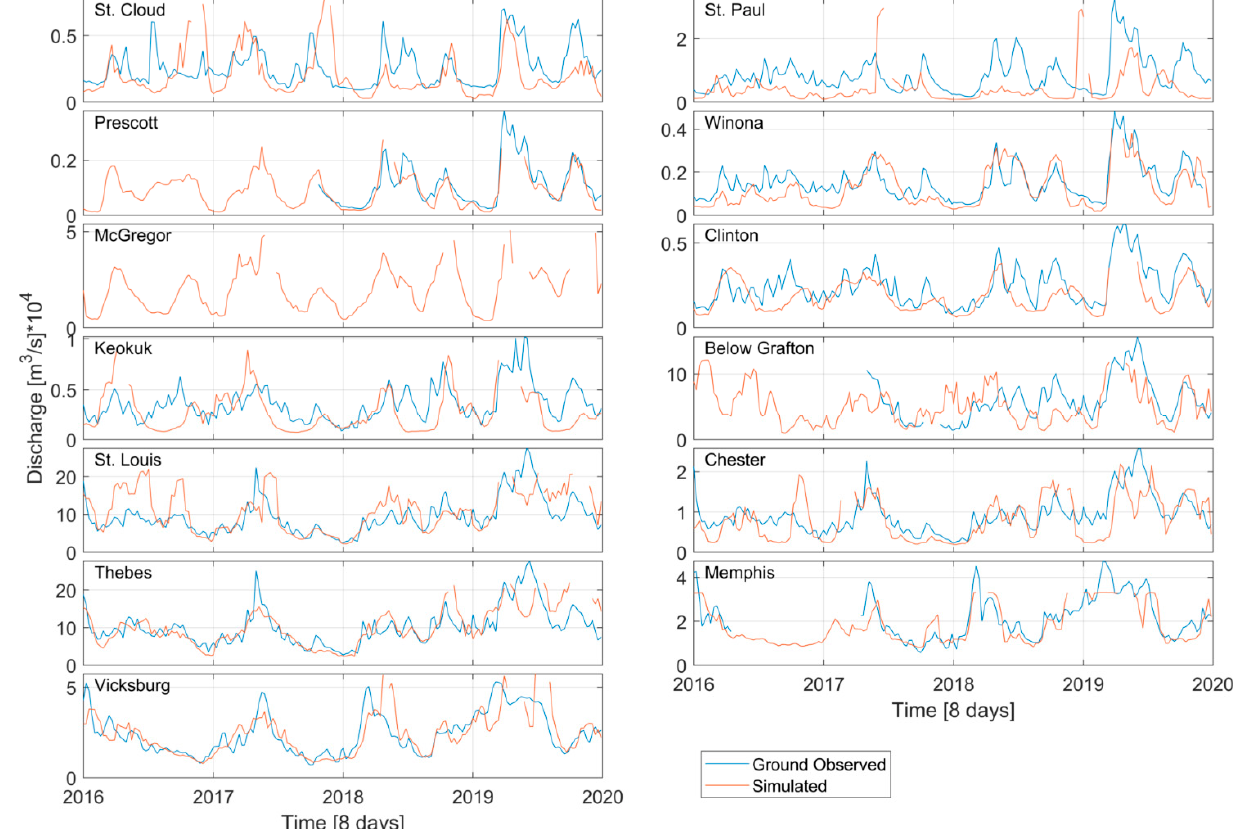
Figure 7. Validation phase: Comparison between the observed and simulated discharges.